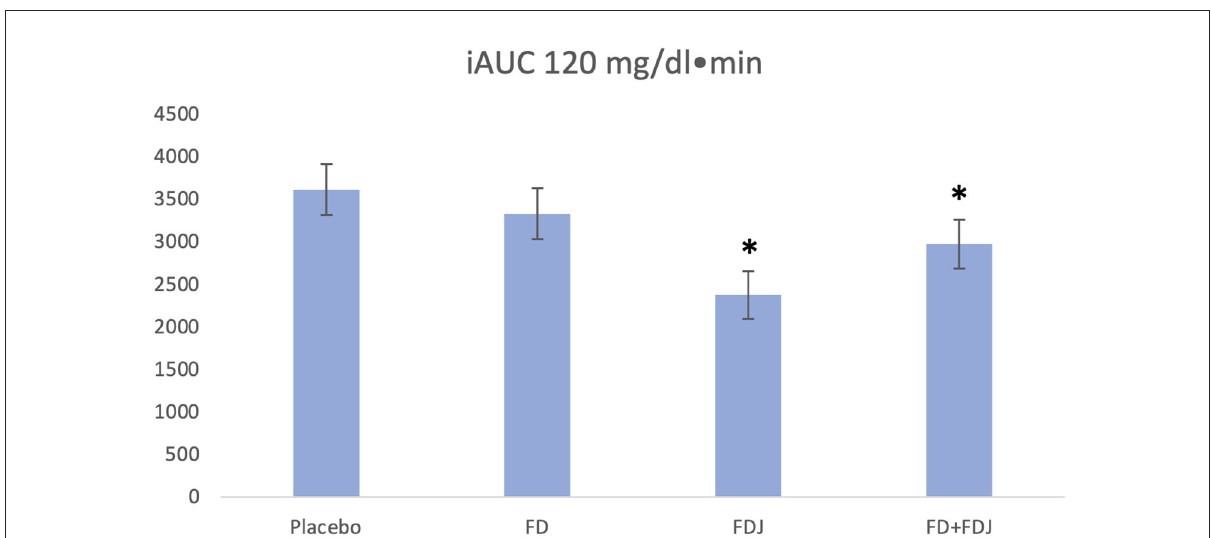
FIGURE1 iAUC 0 − 120 values adjusting for subject and physical activity in the 120min before or after the beginning of a meal. Covariates appearing in the model are evaluated at the following values: total carbohydrates = 65.3g, total protein = 21.3g, total fats = 25.5g. *p < 0.001.